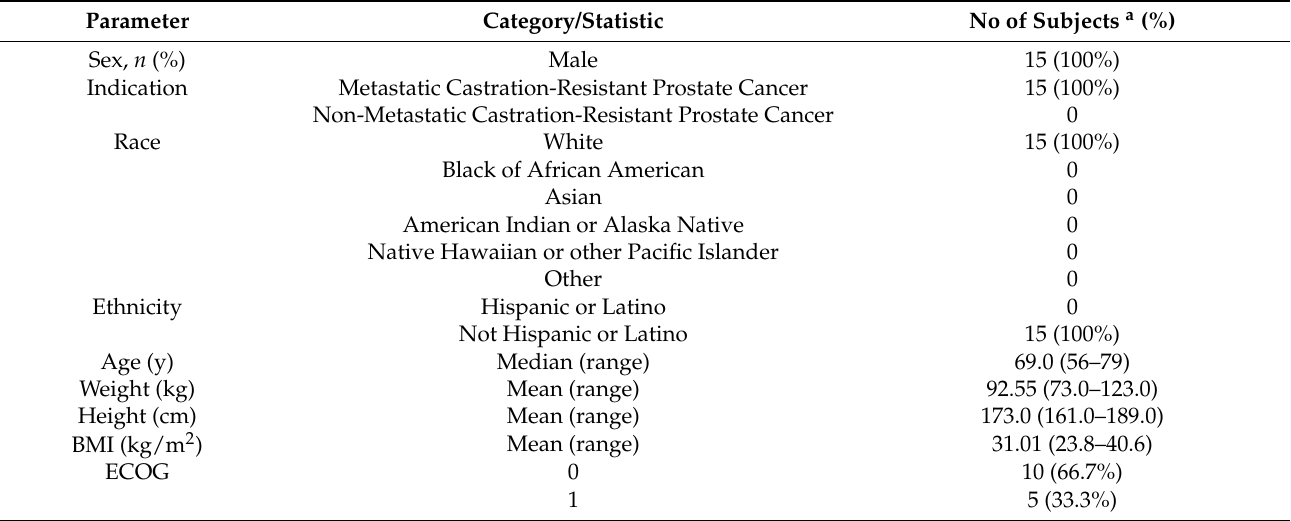
Table 1. Summary of demographics and baseline characteristics of patients enrolled in this study.